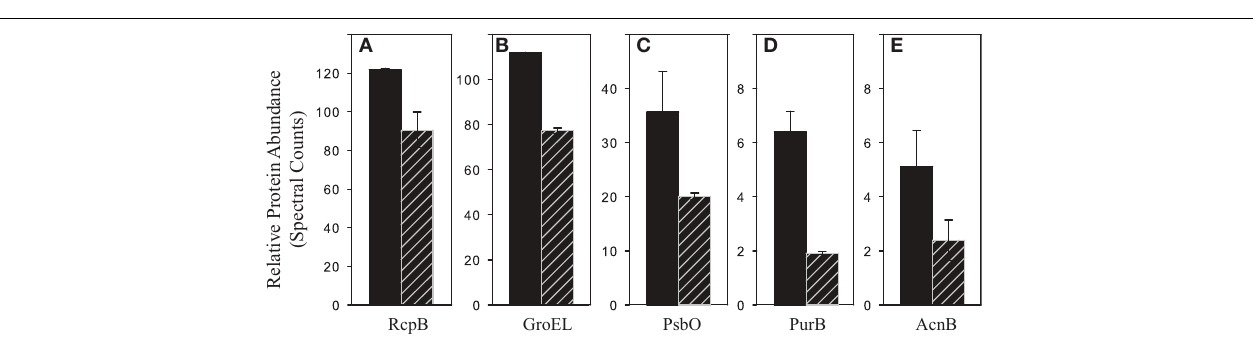
PSIIextrinsicprecursor(PsuB), (G) SYNW0486anchorpolypeptideL CM (ApcE), (H) SYNW1264 peptidyl-prolyl cis-trans isomerase, (I) SYNW0082 riboflavin synthase subunit b (RibH), (J) SYNW2224 possible porin (Som, 2224), (K) SYNW2227 possible porin (Som, 2227), (L) SYNW0827 hypothetical protein (Hypo,0827), (M) SYNW0406hypotheticalprotein(Hypo,0406), (N) SYNW0908 hypothetical protein (Hypo, 0908), and (O) SYNW0670 hypothetical protein (Hypo, 0670). Error bars are the standard deviation of duplicate injections.